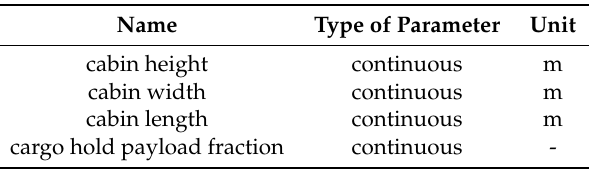
Table 2. Optional requirements for cabin and fuselage.